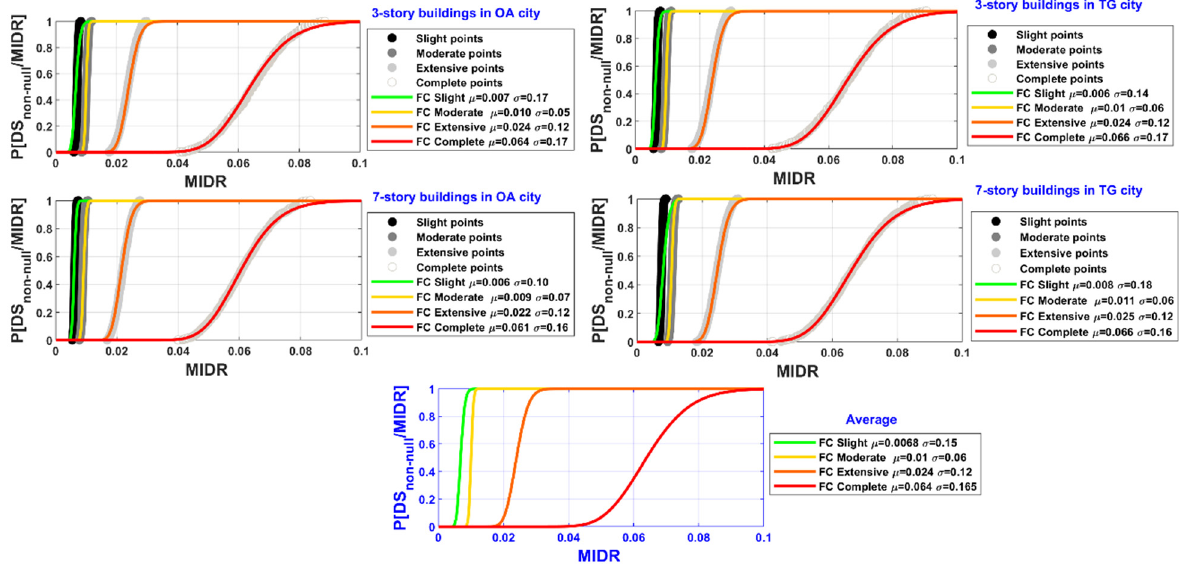
Figure 11. Probabilistic fragility curves of the DS non-null for the buildings in OA and TG cities as functions of the MIDR.